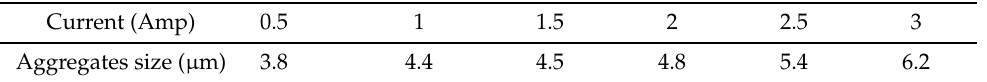
Table 4. Effects of electromagnetic actuation on aggregate size for 0.5 µ m MNPS, with 30 µ L densities after 1 s.